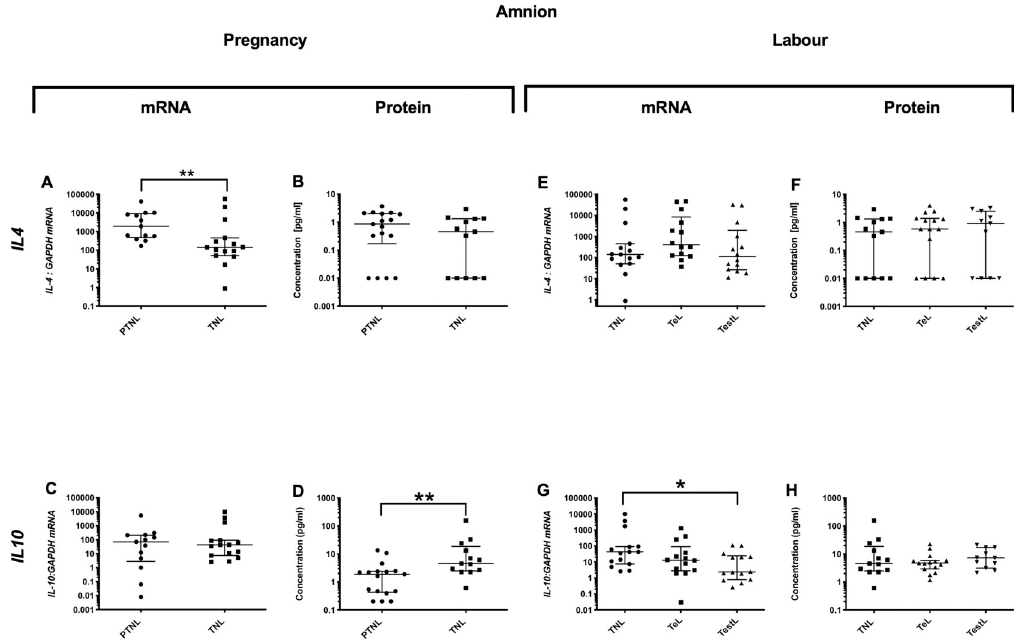
Fig 2. Anti-inflammatory cytokines changes in the amnion. Amnion tissue levels of cytokines from four groups of women (mean gestational age ± SD in each case), PTNL (33.8 ± 1.7 weeks, n = 12), TNL (39.3 ± 0.9 weeks, n = 13), TeL (cervical dilatation < 3cm, 38.6 ± 1.2 weeks, n = 15) and TestL (cervical dilatation > 3cm, 39.6 ± 1.2, n = 11) were compared. Tissue levels of the cytokines were quantified using Bio-plex human cytokine 19-plex-array kit (Bio-rad) as describe in Materials and Methods . A subset of amnion samples, PTNL (33.3 ± 1.9 weeks, n = 13), TNL (39.0 ± 1.0 weeks, n = 15), TeL 38.5 ± 1.3 weeks, n = 14) and TestL (39.4 ± 1.1, n = 14) were used to compare the mRNA expression using rtPCR of IL4 and IL10 . Normally distributed data were analysed using a Student’s t-test and for data that were not normally distributed were analysed using a Mann Whitney test. The data are shown as median with interquartile range. The p values are demonstrated by � is p < 0.05 and �� is p <